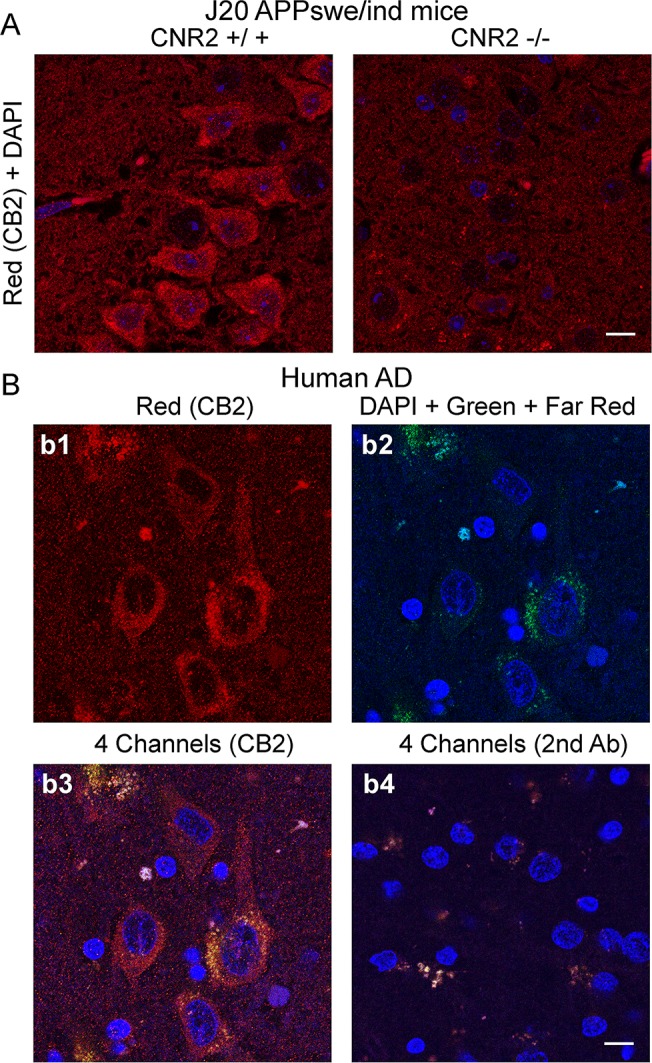
Expression of CB2 receptors in neurons of the hippocampus in a mouse model of amyloidosis (12-mo old J20 APP mice) (A) and in a patient with Alzheimer’s disease (B).(A) Representative confocal images of double immunostaining using DAPI (blue) and CB2 R antibody (H60, Santa Cruz) (red). CA3 area of the hippocampus is shown. To check for specificity of H60 antibody J20 mice were used that either have both (left) or no copies (right) of a CNR2 gene that encodes for CB2 receptor. (B) Confocal images of CB2 staining (b1: red, H60) in neurons of the hippocampus from postmortem brain of a patient with AD. Blue channel was used for detection of DAPI staining (b2: blue). Note the presence of some fluorescent aggregates localized in perinuclear areas of big neurons (shown as pseudo green). These aggregates were visible through different channels (blue, green and far red) suggesting that autofluorescence could be a possible source of these signals. Green and far red channels were used to detect these non-specific signals (b2). b3 shows the composite of b1 and b2. b4 shows the composite of the four channels for an image stained only with secondary antibody. Note the presence of fluorescent granules positive on all channels (white color). Scale in A and B is 10 μm.